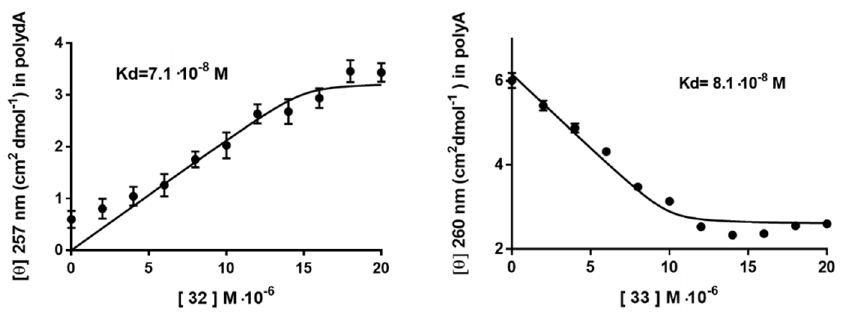
Figure 5. CD titration data of polydA and polyA, with 32 and 33 , respectively.